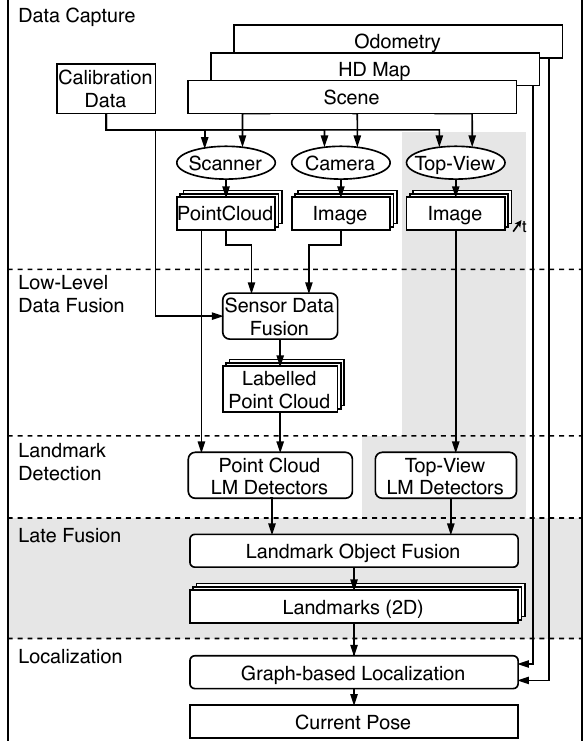
Figure 4. Concept on vehicle self-localization with low-level data fusion of camera and laser scanner data extended by the presented top-view system. The base of this method is given in (Albrecht et al., 2019), our novel impact is highlighted in